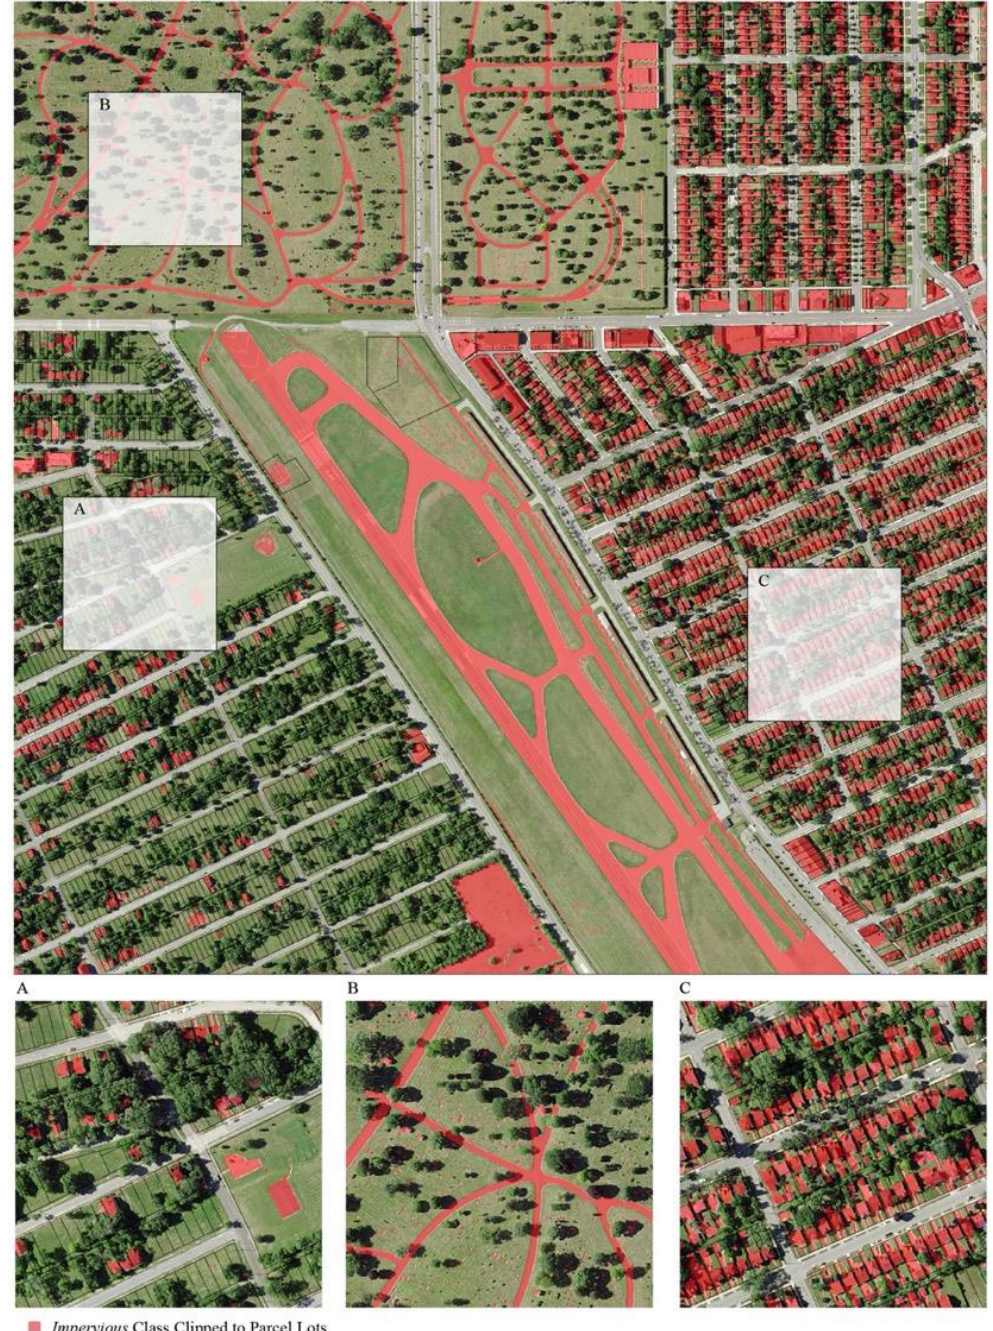
Figure 14. NAIP 2018 impervious surfaces on parcel lots. The shaded areas (A, B and C) in the upper portion of the figure are represented separately at higher resolution in the lower part of the figure.